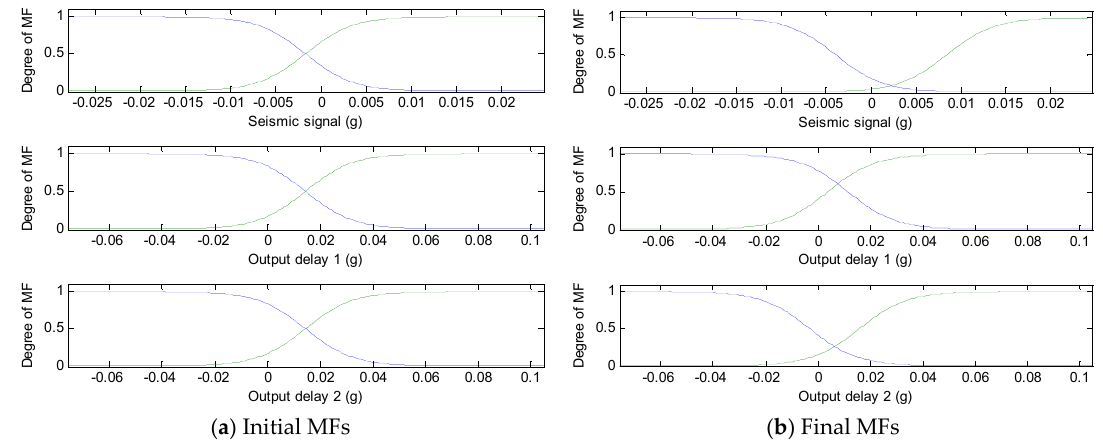
Figure 8. Initial ( a ) and final ( b ) membership functions of model 3. Table 4. Adaptive neuro-fuzzy inference system (ANFIS) models performance evaluation. Model